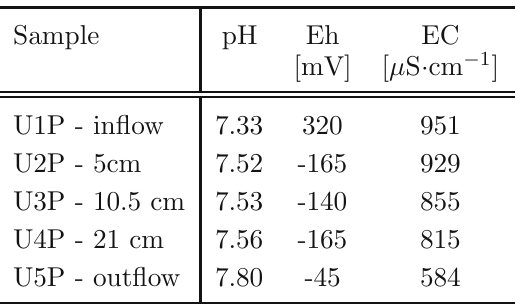
Table 3 Representative field